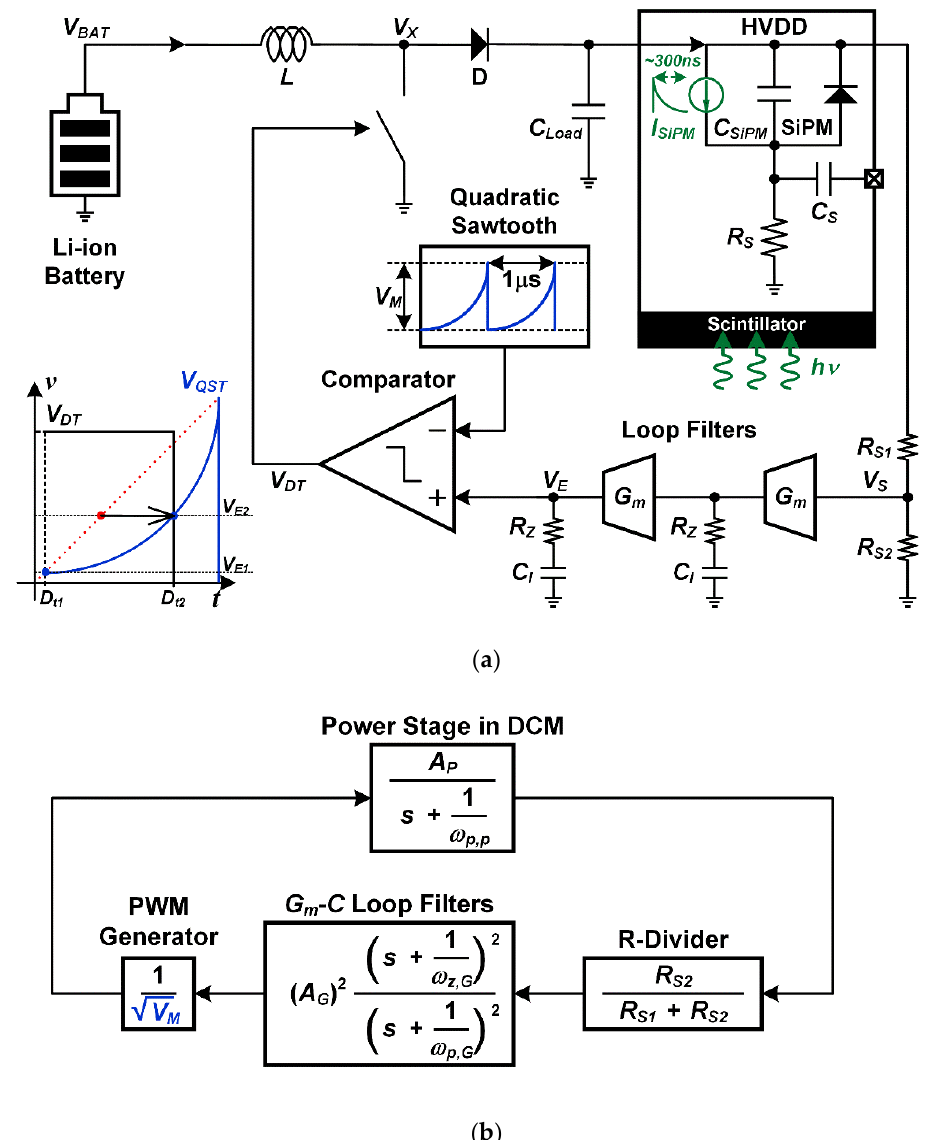
Figure 6. Basic concept of proposed boost converter: ( a ) block diagram, ( b ) small-signal model.